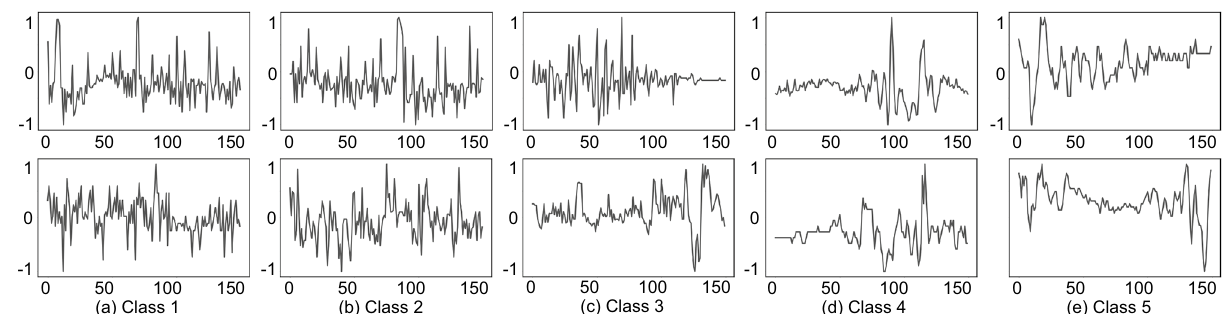
Figure 2. Visualization of PD-sEMG dataset. Each sEMG sequence is annotated with a class label among the five classes defined by the internationally accepted MDS-UPDRS 19 rating scale. The class label indicates the tremor severity where Class 5 represents severe and Class 1 represents normal. It is clear that the sEMG features change gradually from Class 1 to Class 5 corresponding to the fact that the physiological states are naturally continuous. The discrete classification labels are only coarse approximations of the real situation and cannot capture the smooth transitions between neighbouring classes.